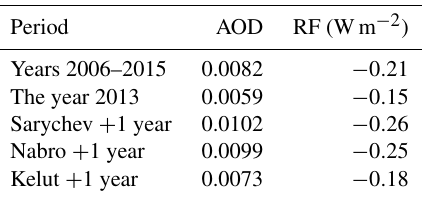
Table 3. Global mean stratospheric AOD and radiative forcing for the years 2006–2015, the year 2013, and the first year after the vol- canic eruptions in Fig.